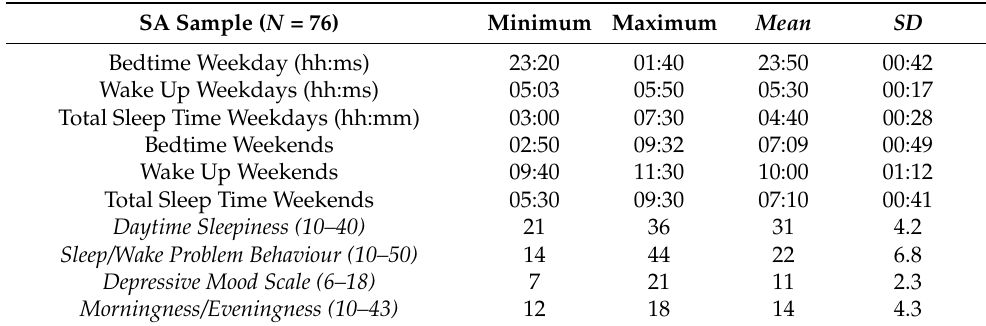
Table 2. Detailed summaries of the sleep patterns for TD adolescents in SA, based on the scores derived from the School Sleep Habits